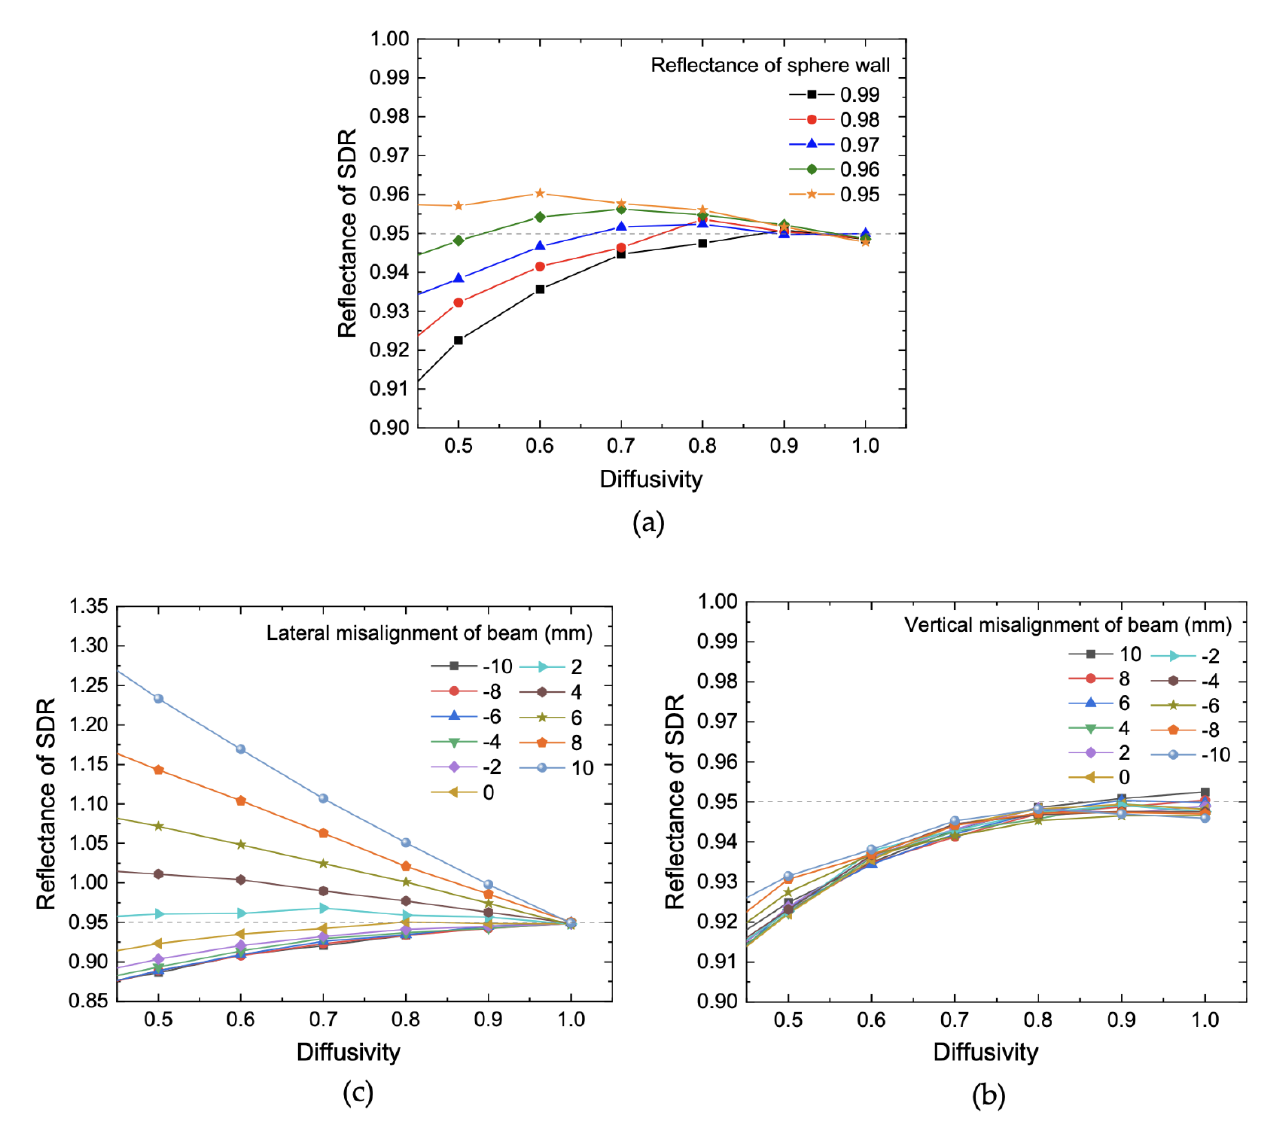
Figure 7. Virtually measured reflectance with the absolute reflectometer with varying system parameters: ( a ) diffusivity and reflectance of the sphere wall, ( b ) diffusivity and vertical misalignment of the incident beam, ( c ) diffusivity and lateral misalignment of the incident beam.